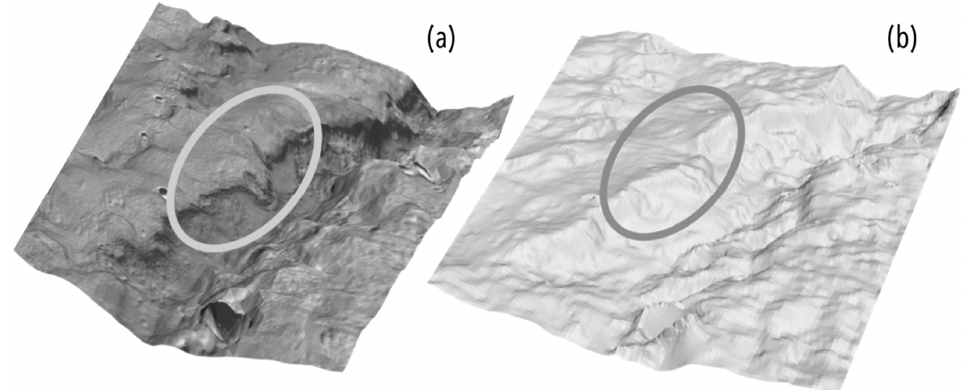
Figure 11. Comparison between vertical exaggeration of topographies (exaggeration factor of 20) for the HRSC DTM with a CTX image mapped on it ( a ) and the HCPC DTM ( b ). The edge of the circled plateau was straightened by photoclinometry.